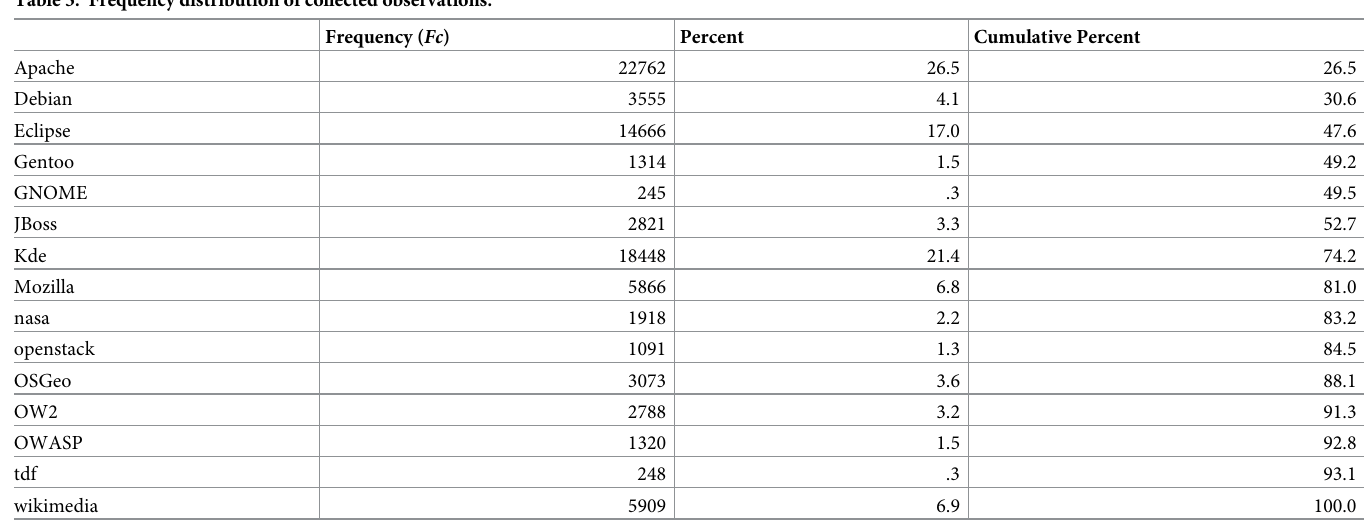
Table 3. Frequency distribution of collected observations.